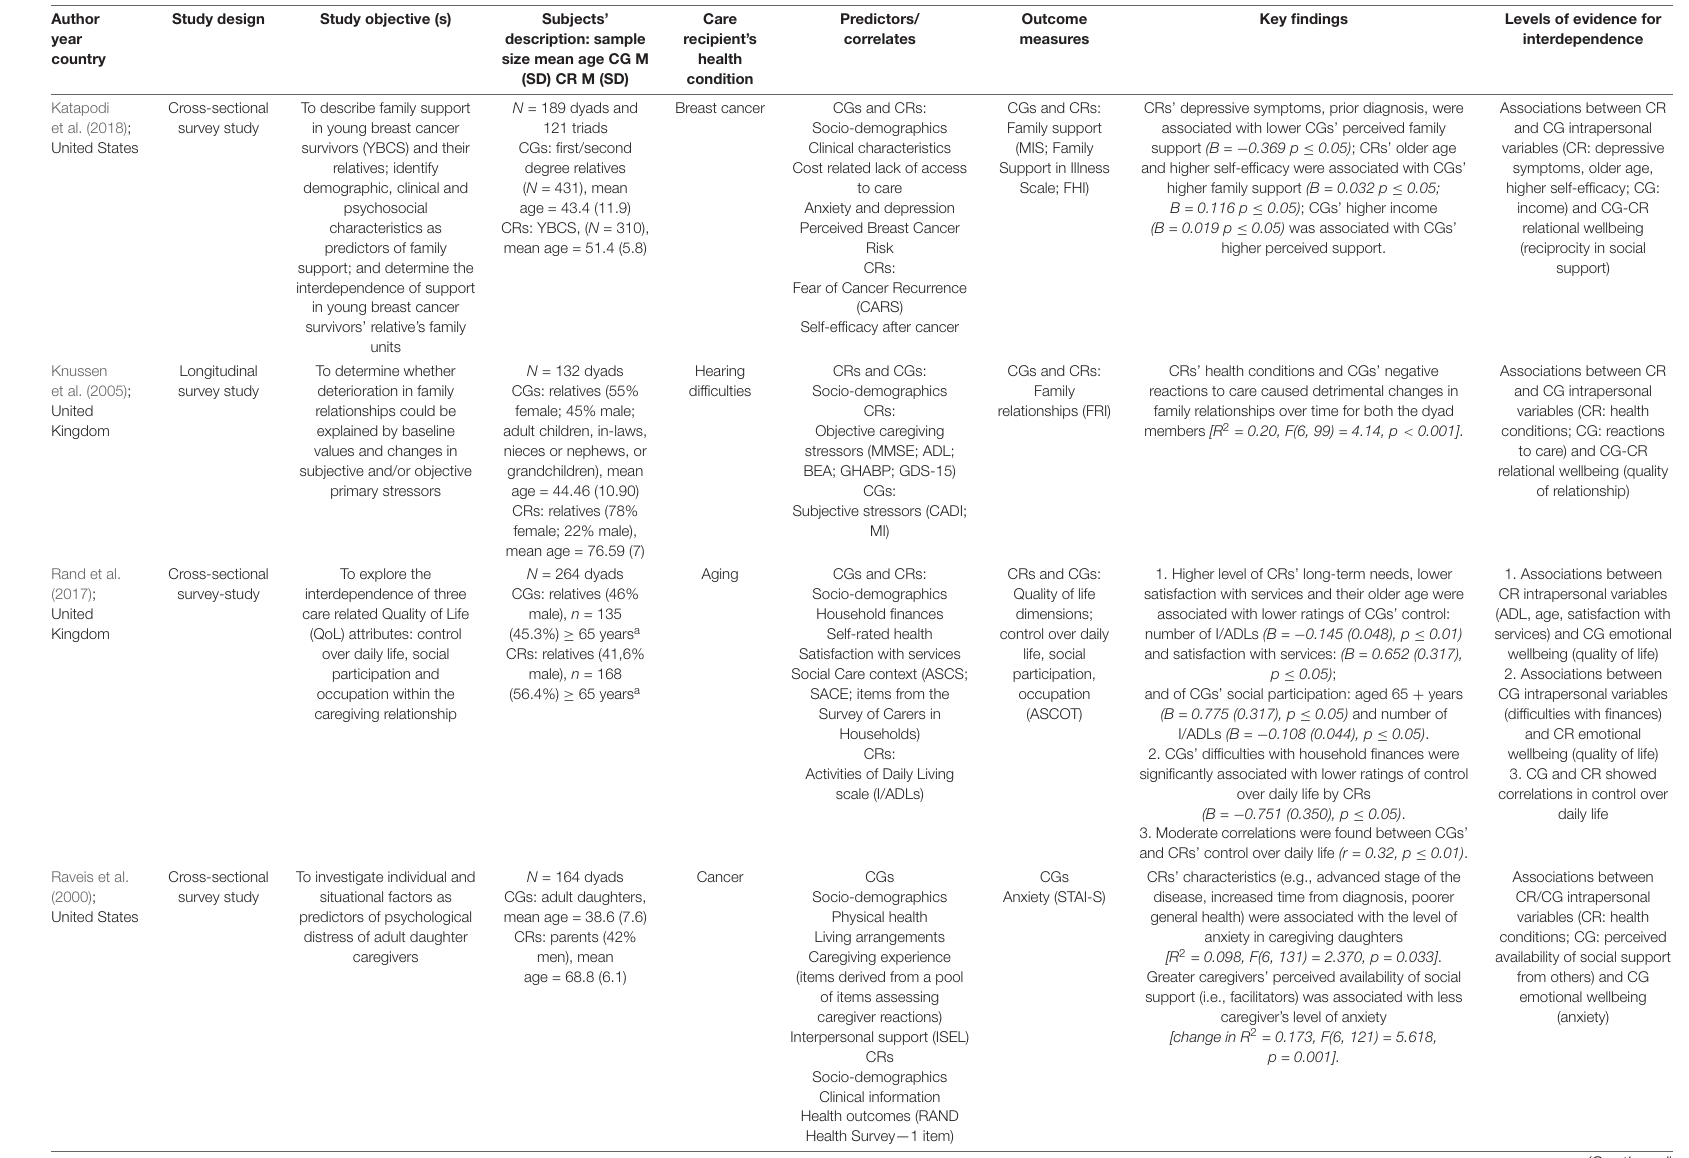
Health outcomes (RAND Health Survey—1 item)